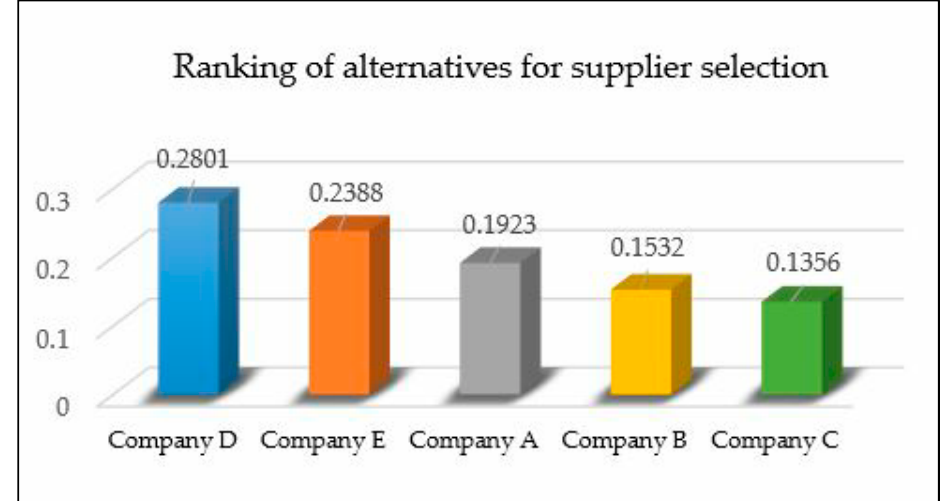
Figure 6. Ranking of alternatives for supplier selection.